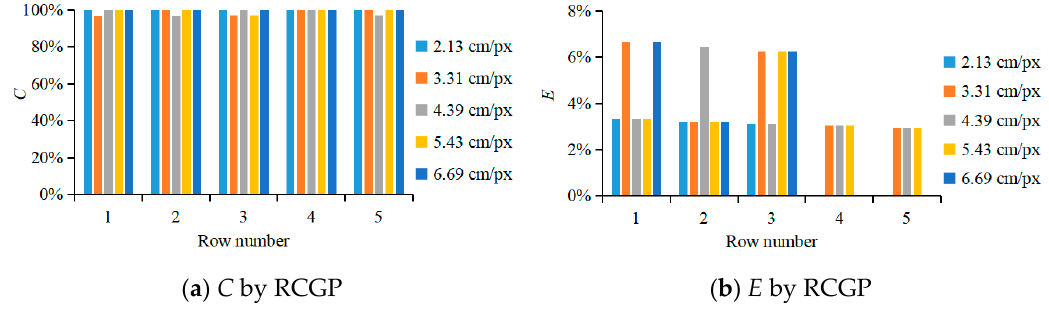
Figure 4. Performance of column detection with orchard canopy data.